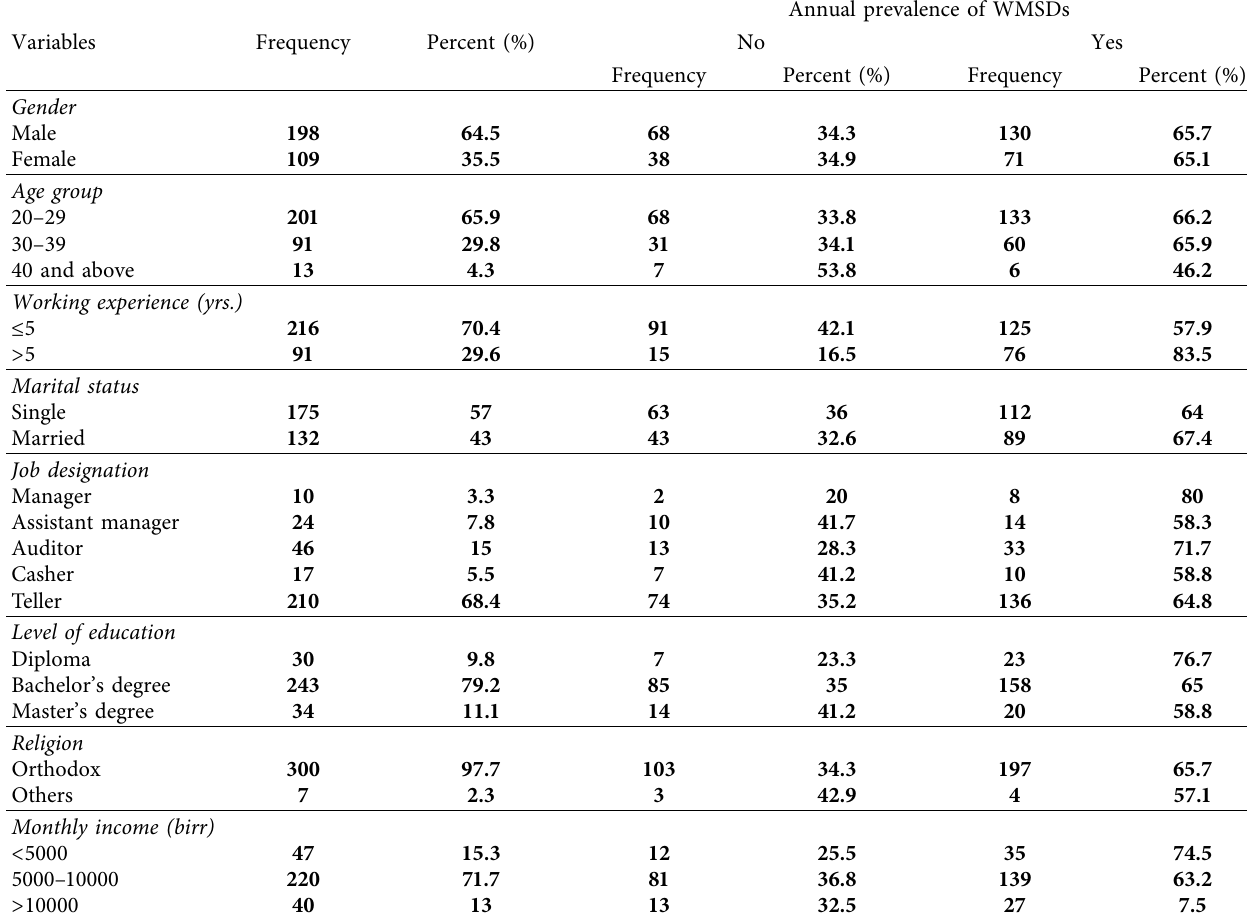
Table 2: Individual, psychosocial, and lifestyle factors of bankers working in Mekelle city, Tigray, Ethiopia, May 2018 ( n � 307).